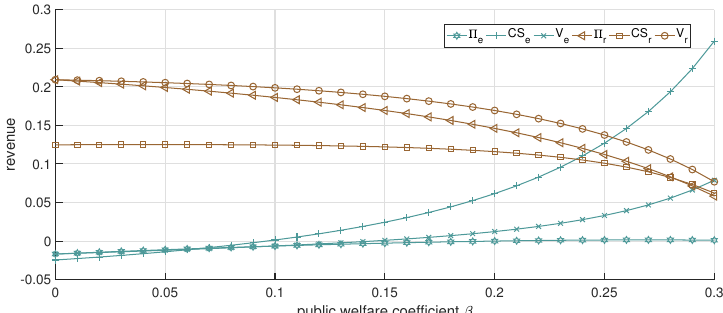
Figure 8. The impact of changes in β on CS and V (the dual-channel strategy p 0 =